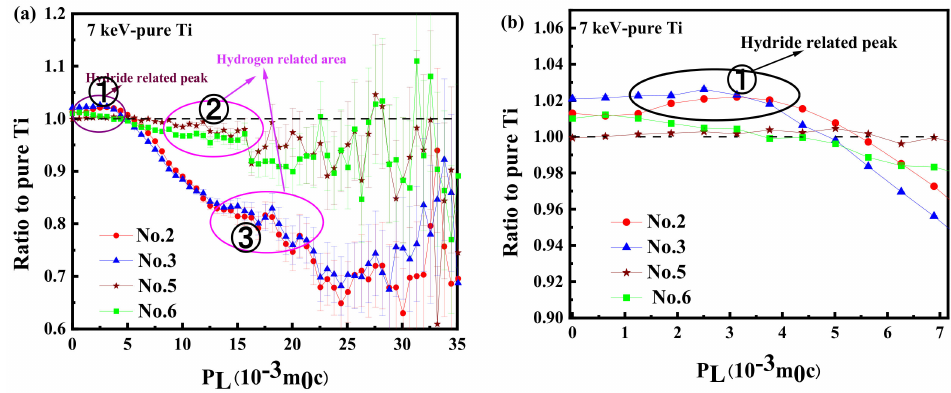
Figure 5. ( a ) CDB-PAS ratio curves of pure titanium samples before and after electrolytic hydrogen charging. ( b ) CDB-PAS ratio curves of the momentum region 0~6 × 10 − 3 m 0